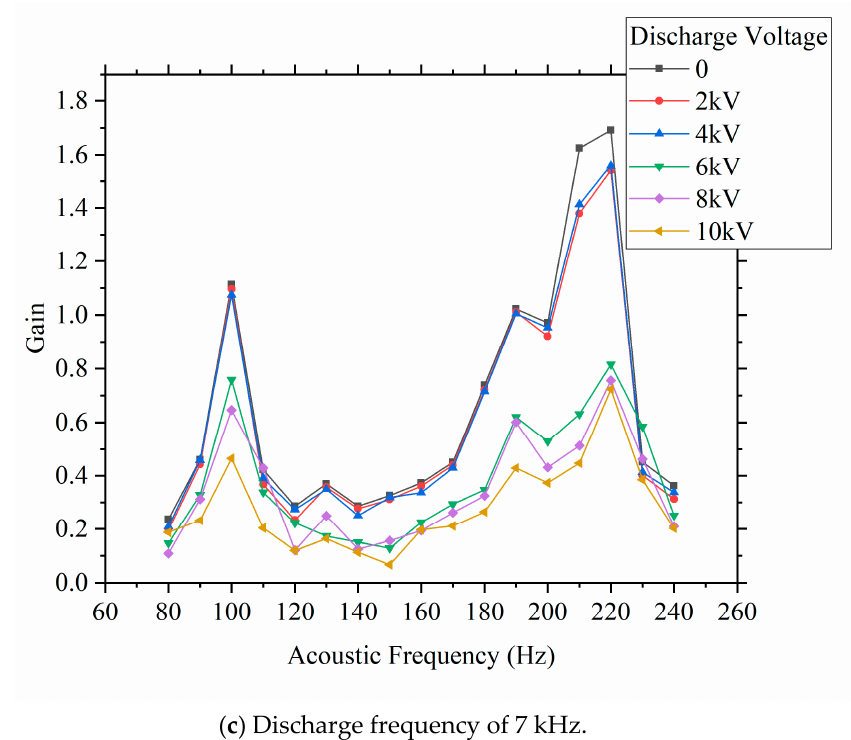
Figure 6. The effects of plasma on flame transfer function with different acoustic frequencies.